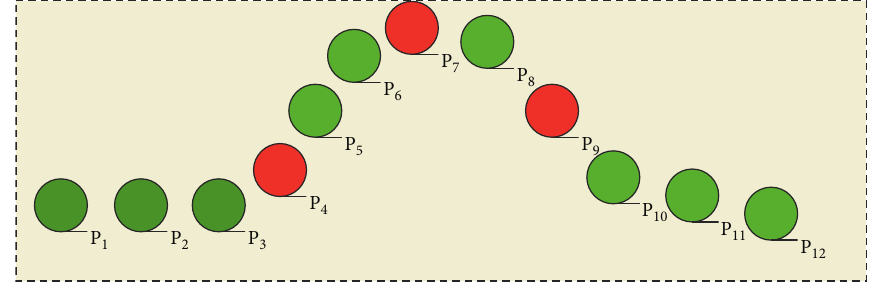
Figure 1: Key points after nonmaximum